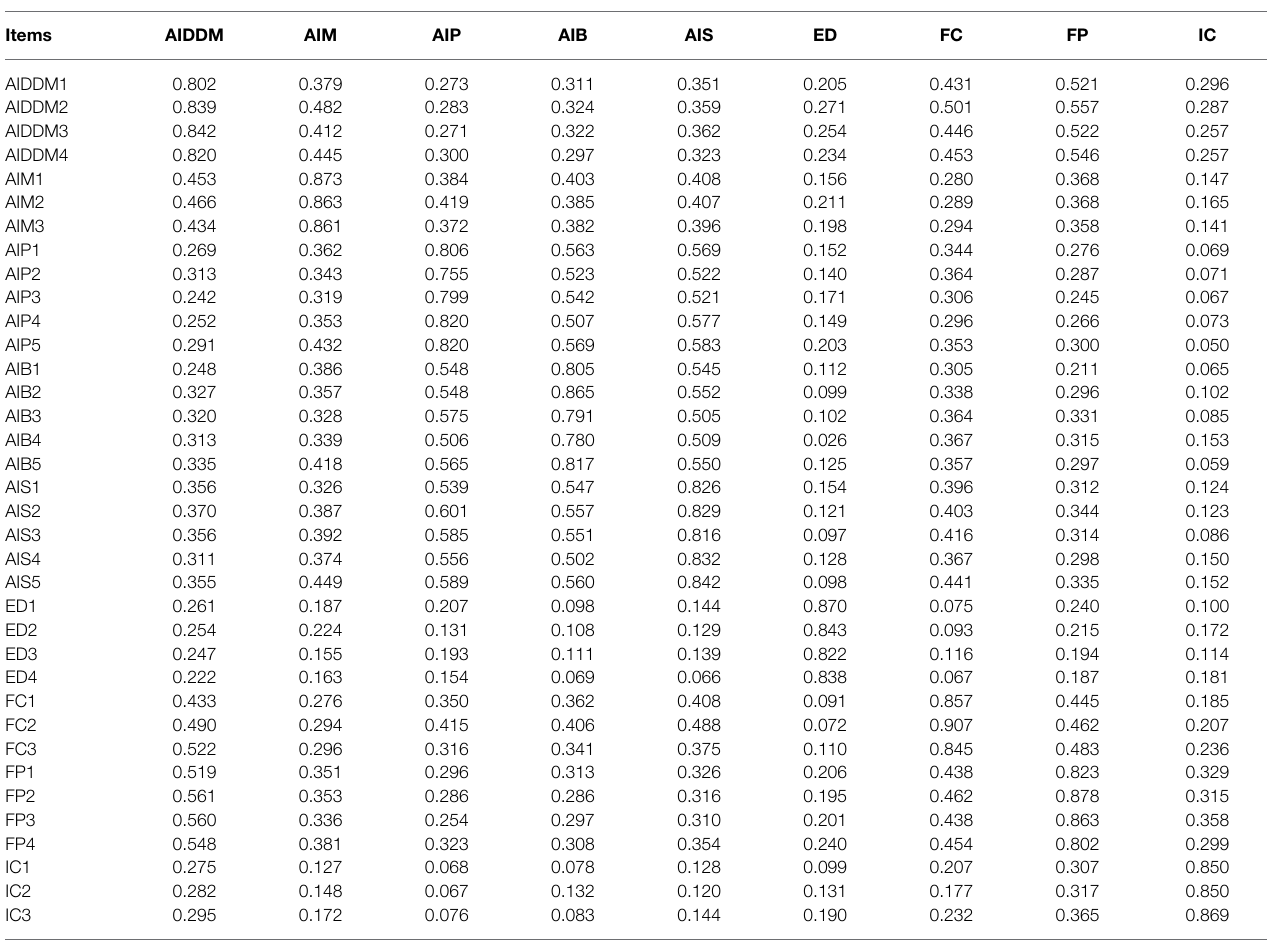
TABLE 5 | Factor loadings and cross